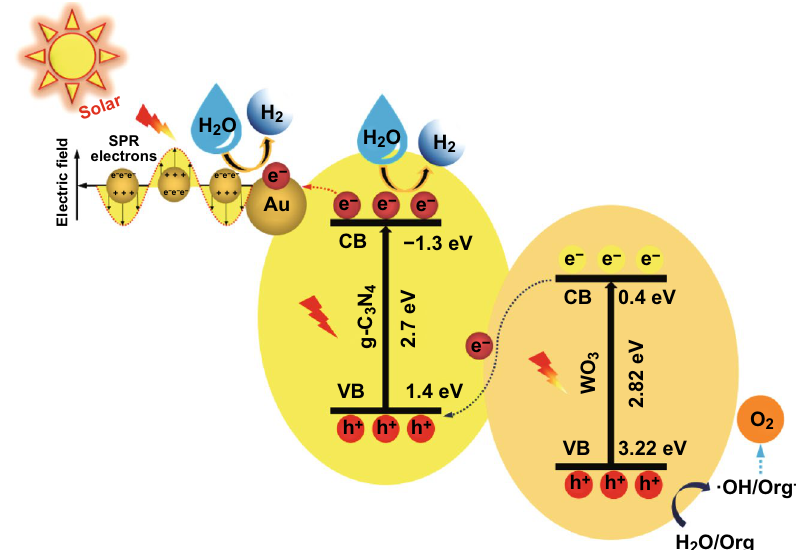
Fig. 7 Schematic for the energy band gaps, charge carriers separation and transfer, and the photocatalytic processes over 4Au/6WO 3 /CN com‑